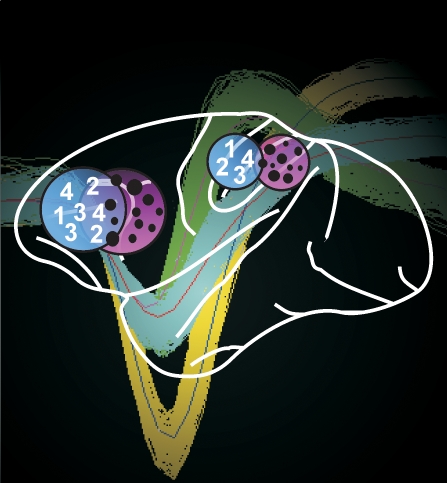
Prefrontal neurons link numerical categories to visual signs.